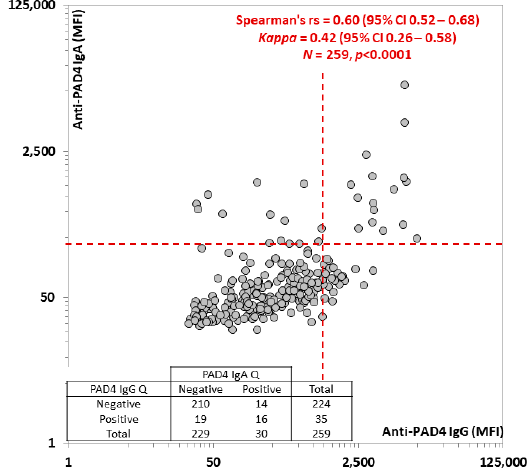
Figure 3. Correlation between anti-protein-arginine deiminase (PAD) 4 IgG and IgA levels. The Spearman correlation analysis between anti-PAD4 IgG and IgA is shown. The red dashed line represents the cut-offs. Spearman’s rs, the kappa coefficient, number of patients included, and p -values are shown in the graph. The qualitative agreement is shown in the table. Abbreviations: MFI: median fluorescent intensity; PAD: protein-arginine deiminase; Q: qualitative.